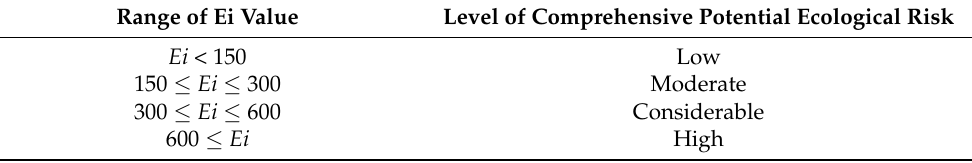
Table 1. Classification of potential ecological risk for heavy metals in sediments. Range of Ei